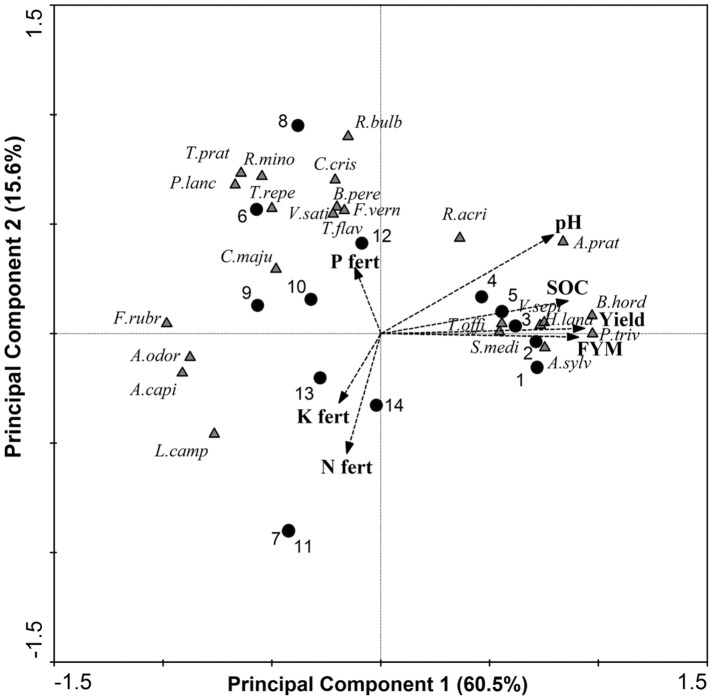
Principal components analysis (PCA) illustrating the variation in the plant species (∆) dataset at Palace Leas.Environmental variables including soil and plant variables (dotted arrow) and treatment plot number (●) are overlain. A. capi = Agrostis capillaris, A. prat = Alopecurus pratensis, A. odor = Anthoxanthum odoratum, A. sylv = Anthriscus sylvestris, B. pere = Bellis perennis, B. hord = Bromus hordeaceus, C. maju = Conopodium majus, C. cris = Cynosurus cristatus, F. rubr = Festuca rubra, F. vern = Ficaria verna, H. lana = Holcus lanatus, L. camp = Luzula campestris, P. triv = Poa trivialis, R. acri = Ranunculus acris, R.bulb = Ranunculus bulbosus, R. mino = Rhinanthus minor, S. medi = Stellaria media, T. offi = Taraxacum officinale, T. prat = Trifolium pratense, T. repe = Trifolium repens, T. flav = Trisetum flavescens, V. sati = Vicia sativa, V. sepi = Vicia sepium.